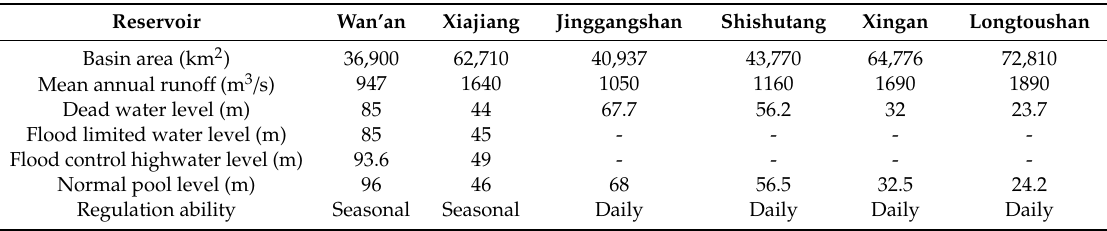
Figure 4. The skeleton of the middle and lower reaches of Ganjiang River basin flood control system. Table 1. Characteristic parameters of reservoirs and navigation-power junctions.